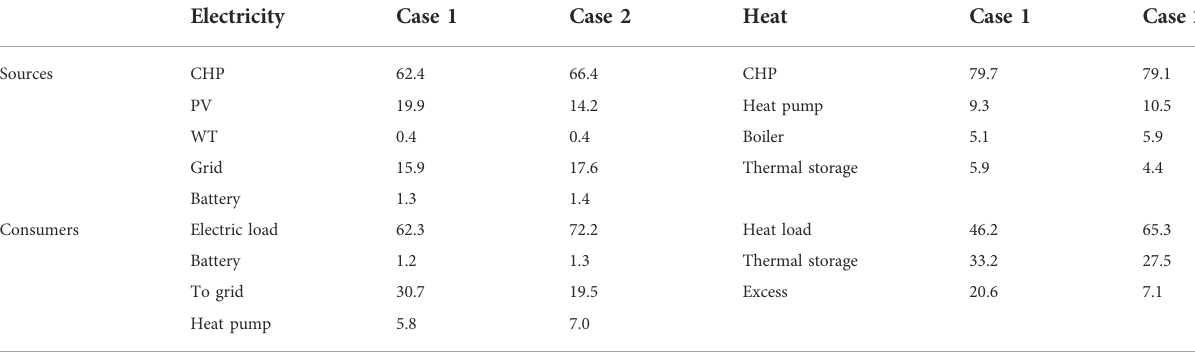
TABLE 6 Sectors of electrical and thermal sources and consumers in two cases.